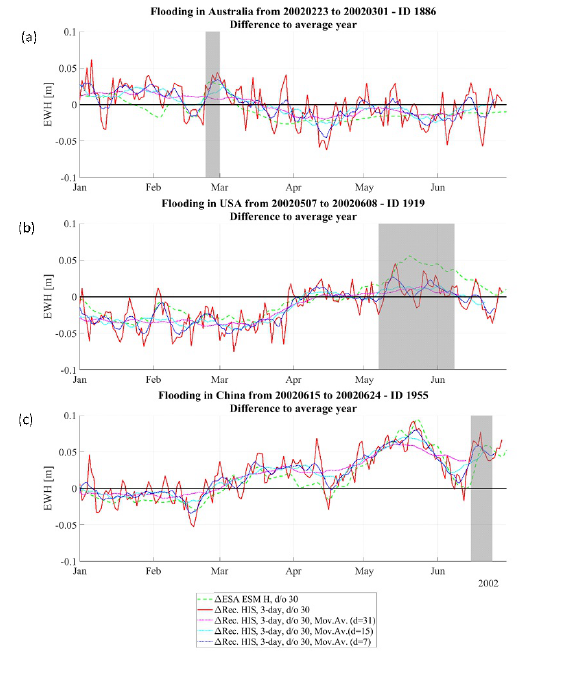
Fig. 7. The reconstructed HIS signal (by subtracting the AO Dealias- ing products) for the 4 arc degree radius areas directly (red), with a moving average with d=31 (magenta), d=15 (cyan) and d=7 (blue) compared to the hydrological component of the ESA ESM